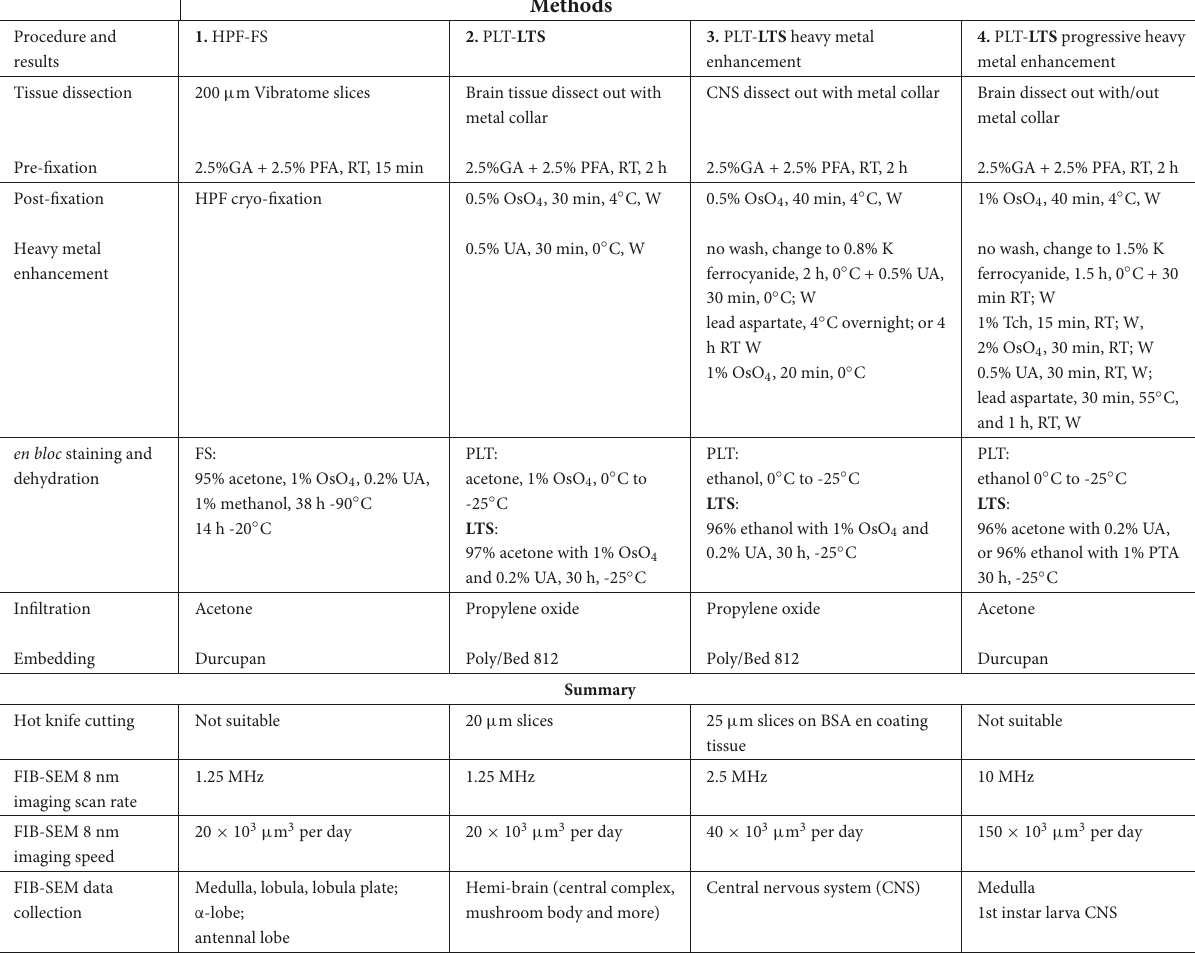
TABLE 1 Drosophila sample preparation procedures and